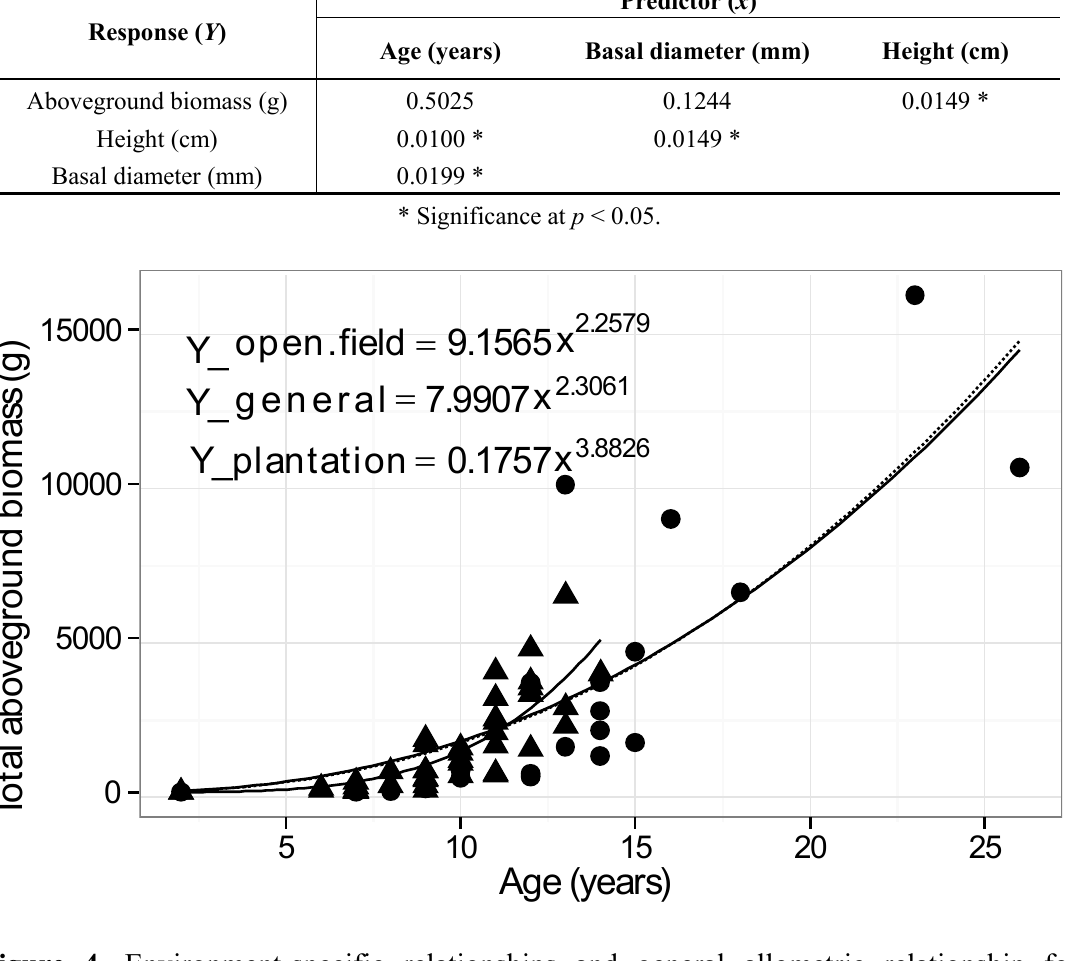
Figure 4. Environment-specific relationships and general allometric relationship for glossy buckthorn between age (years) and total aboveground biomass (g). Triangle symbols = Plantation data points; Circle symbols = Open field; Dotted line = general model (plantation + open